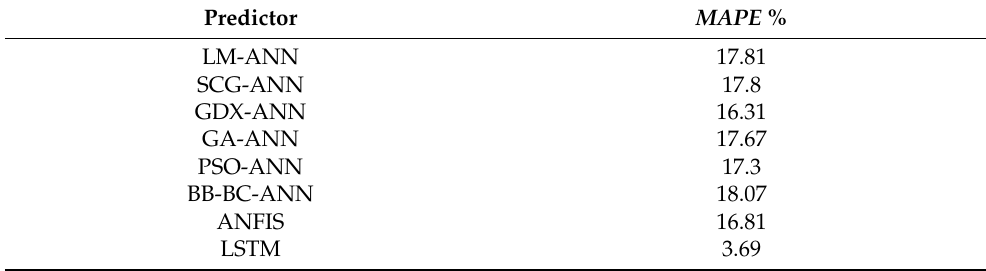
Table 6. MAPE results for January 2021.